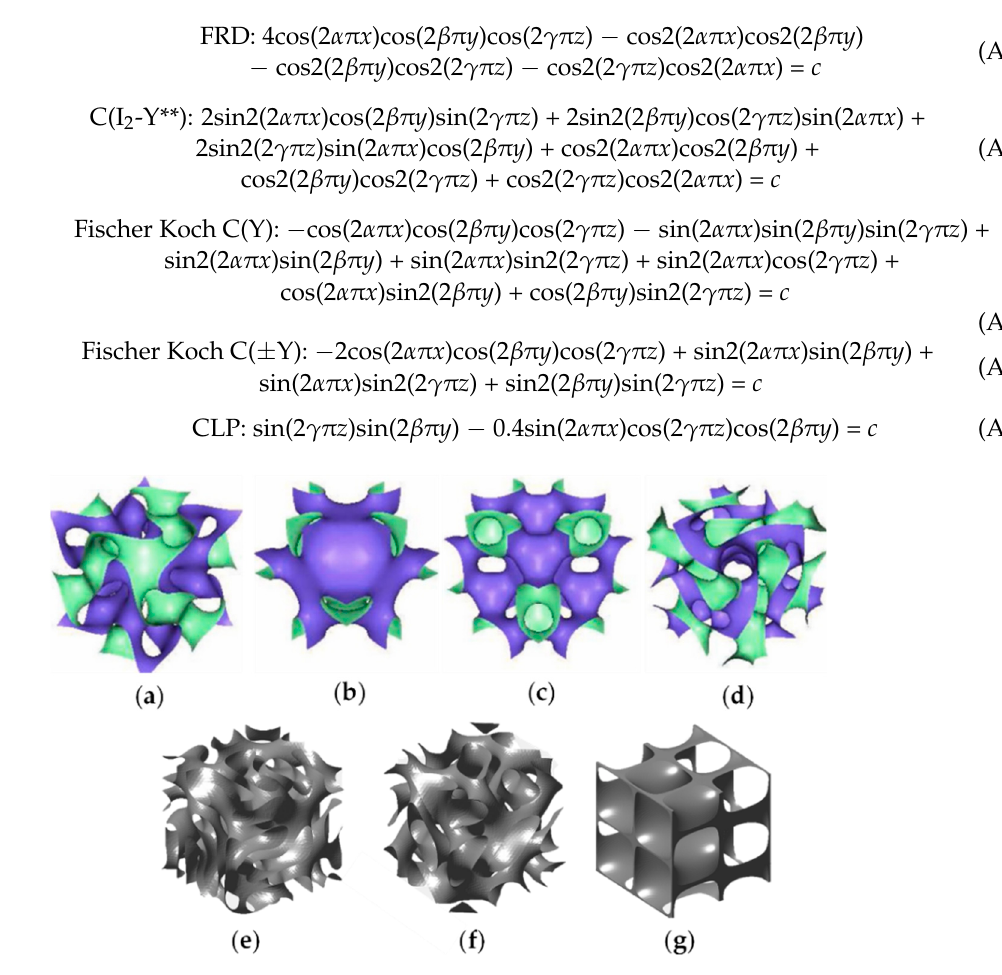
Figure A1. Minimal surfaces for different TPMS topologies found in the flow and heat transfer research: ( a ) Fischer Koch S [55]; ( b ) Neovius [55]; ( c ) FRD [55]; ( d ) C(I 2 -Y**) [55]; ( e ) Fischer Koch C(Y) [82]; ( f ) Fischer Koch C( ± Y) [82]; ( g ) CLP